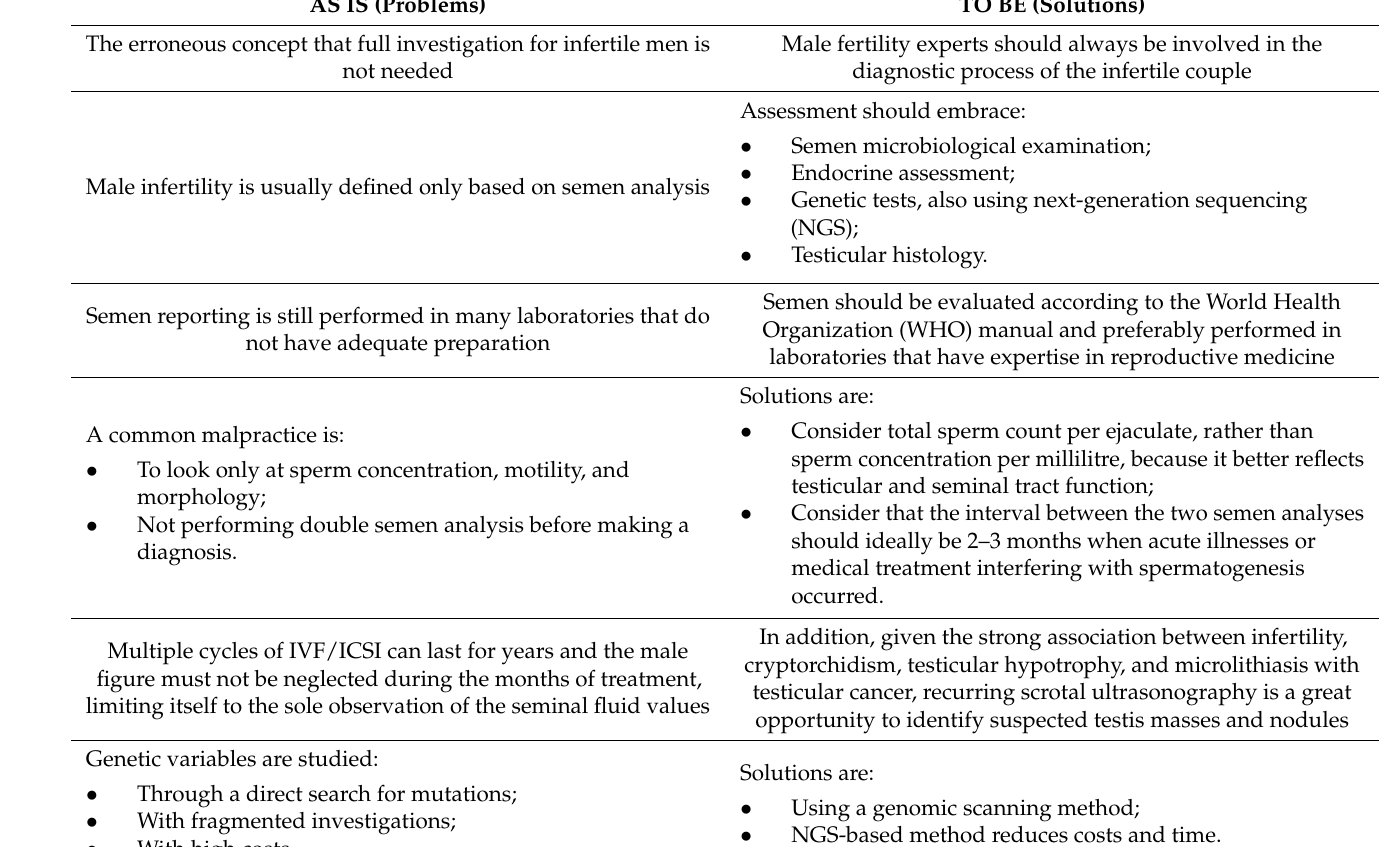
Table 1. The problems affecting gender impact in ART are presented as “as is”. Strategies to reduce gender differences impact are presented as “to be”. Results are strictly linked to gynaecological and genetic assessment strategies in ART. AS IS